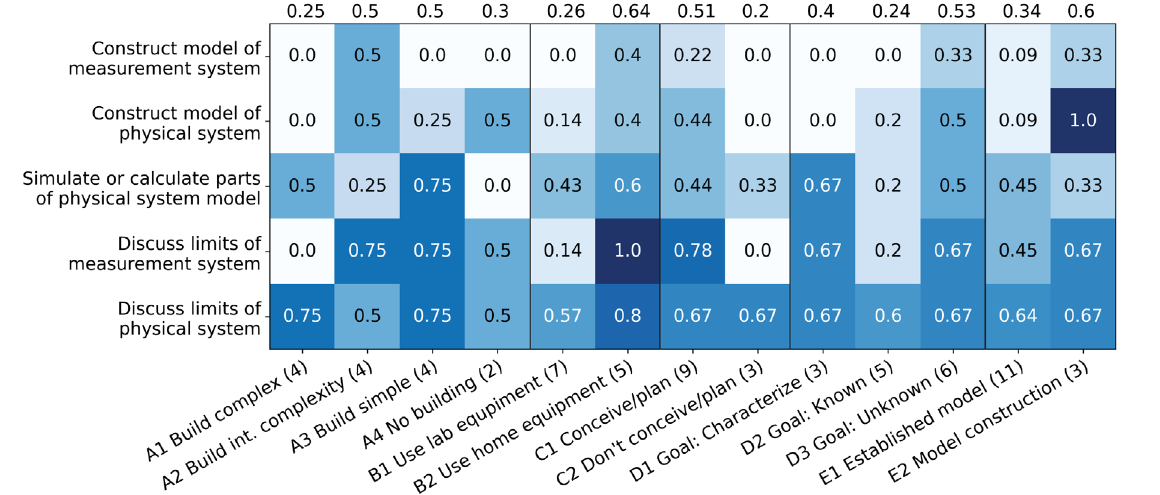
FIG. 4. Fraction of projects with a specified feature (columns, organized by category) assigned the engage with models subcodes (rows). The numbers in parentheses following the abbreviated feature names are the number of projects with each feature, and the numbers on top are averages over each column. The higher the column average, the more the feature may be associated with engagement with models on average. The modeling codes are sorted by average over row, so the lower modeling codes more frequently appeared in student